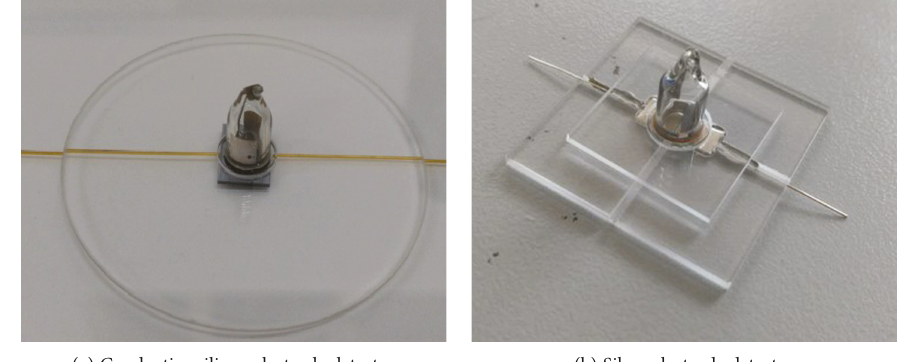
Figure 6: Miniature photoionization detector.